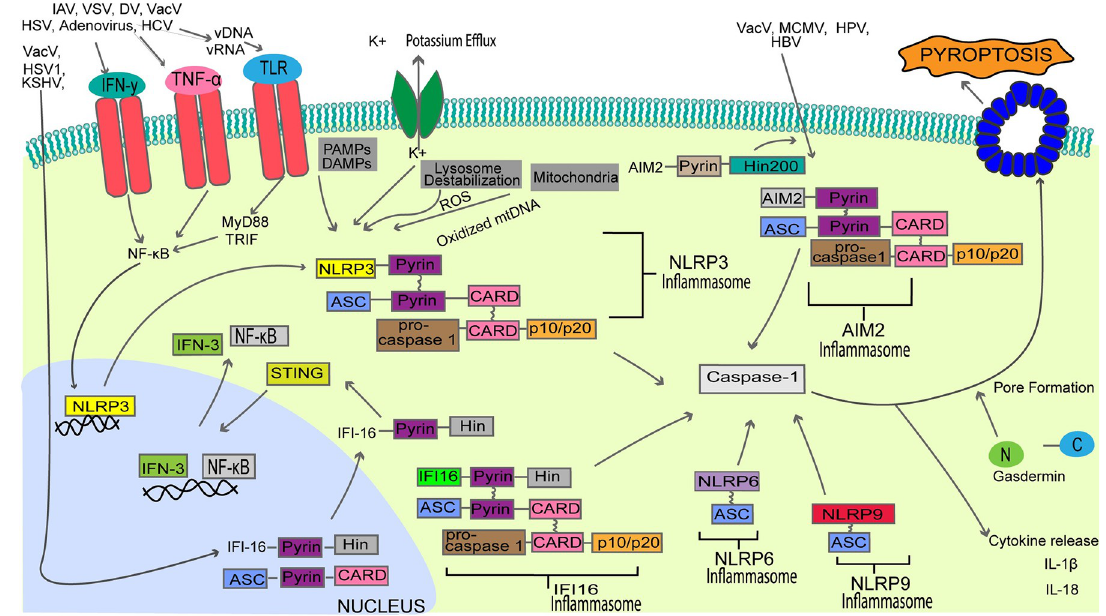
Fig 3. A summary of the major components of the pyroptosis induction pathway following viral infection. Viral nucleic acids can stimulate pyroptosis through the activation of the NLRP3/6/9 inflammasome, AIM2 inflammasome, and IFI16 inflammasome. Inflammasome activation stimulates the recruitment and activation of pro-caspase-1, resulting in the downstream cleavage of gasdermin proteins into C-terminal and N-terminal portions. The N-terminal gasdermin portion catalyzes pore formation and proinflammatory cytokine release. AIM2, absent in melanoma 2; ASC AU : PleaseprovidefulldefinitionforASCinFig 3 abbreviationlistifthisindeedisanabbreviation : , Apoptosis-associated speck-like protein containing a CARD; CARD, caspase activation and recruitment domain; DAMP, damage-associated molecular pattern; DV, dengue virus; HBV, hepatitis B virus; HCV, hepatitis c virus; HPV, human papillomavirus; HSV, herpes simplex virus; IAV, influenza A virus; IFI16, IFN-gamma-inducible protein 16; IFN-3, interferon-3; IFN-y, interferon gamma; KSHV, Kaposi sarcoma–associated herpesvirus; MCMV, murine cytomegalovirus; mtDNA, mitochondrial DNA; NF- κ B, nuclear factor- κ B; NLRP3, Nod-like receptor family pyrin domain containing 3; PAMP, pathogen-associated molecular pattern; ROS, reactive oxygen species; STING, stimulator of IFN genes; TLR, Toll-like receptor; TNF- α , tumor necrosis factor alpha; TRIF, Toll/IL-1 receptor domain-containing adapter inducing IFN-beta; VACV, vaccinia virus; VSV, vesicular stomatitis